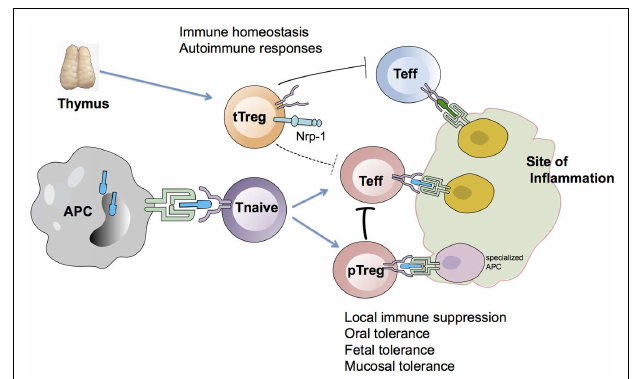
FIGURE 1 | Model depicting the generation and function of tTregs and pTregs . Nrp-1 hi tTregs are generated in the thymus and are important in maintaining immune homeostasis and controlling autoimmune responses. During the course of an immune response, Nrp-1 lo pTregs are generated in response to Ag presentation by specialized APCs and control effectorT cells (Teff) at the site of inflammation. pTregs help in controlling inflammation locally and may be more effective than tTregs at suppressingTeff due to overlapping antigen